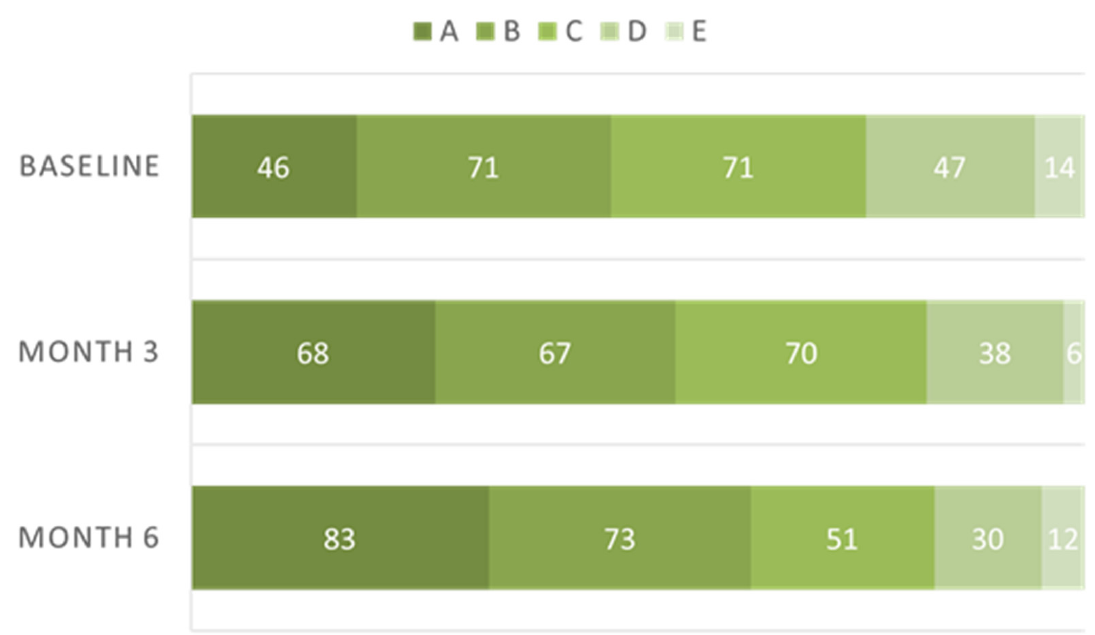
Figure 3. The ranking distribution of Veggie Meter score at three time points. The specifics of each rank were depicted in Figure 1a.